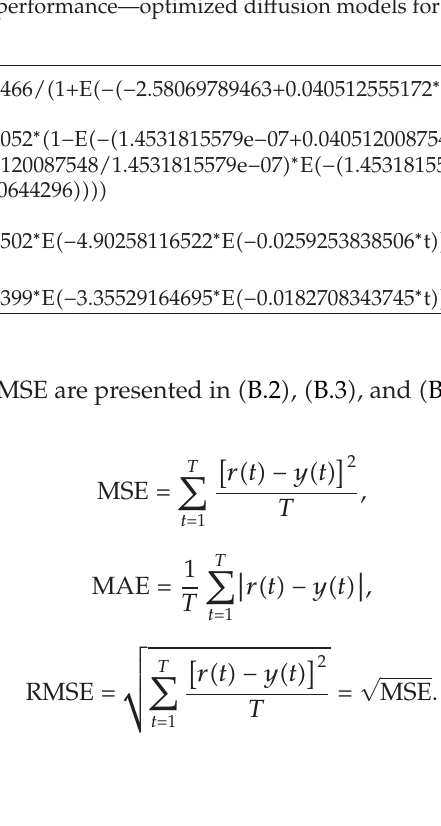
Table 30: Representation of the optimized di ff usion models in forecasting (cid:2) OECD overall (cid:3) . Forecasting performance—optimized di ff usion models for OECD